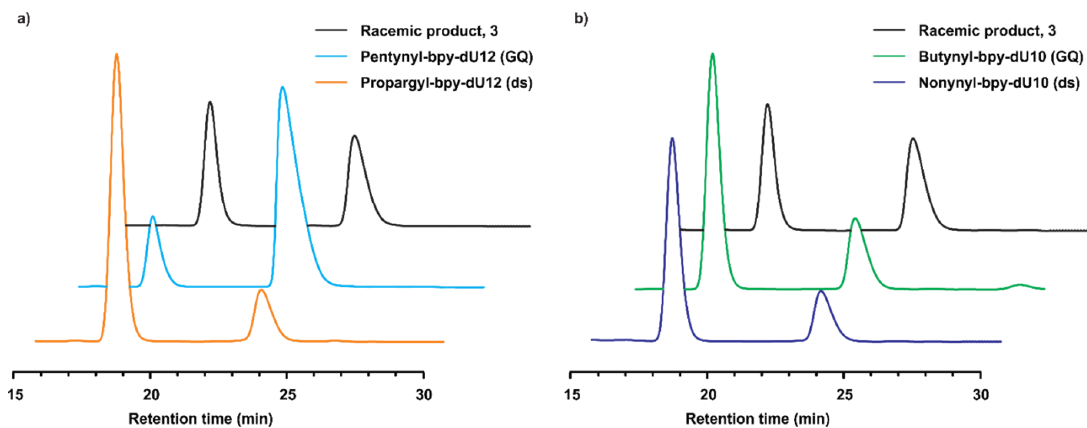
Figure 2. Comparison of chiral HPLC chromatograms of product 3. ( a ) Comparison of the Friedel – Crafts alkylation product 3 using different dU12-modified DNA structures. ( b ) Comparison of the Friedel – Crafts alkylation product 3 using different dU10-modified DNA structures.